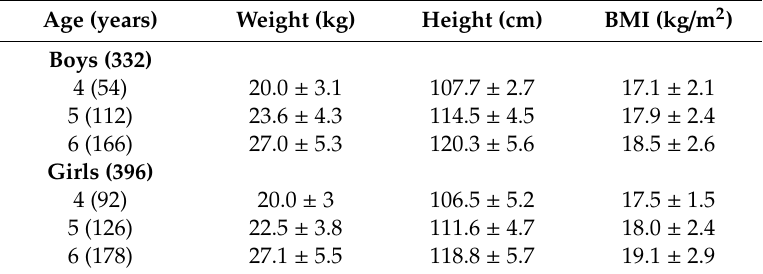
Table 1. Anthropometric characteristics (Mean ± SD), by age and gender.